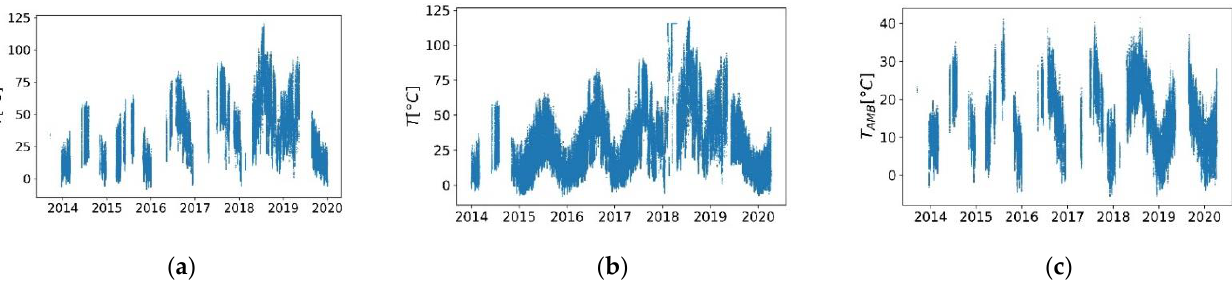
Figure 5. Visualization of the temperature data: ( a ) measured module temperature, ( b ) module temperature with filled in gaps, and ( c ) measured ambient temperature.